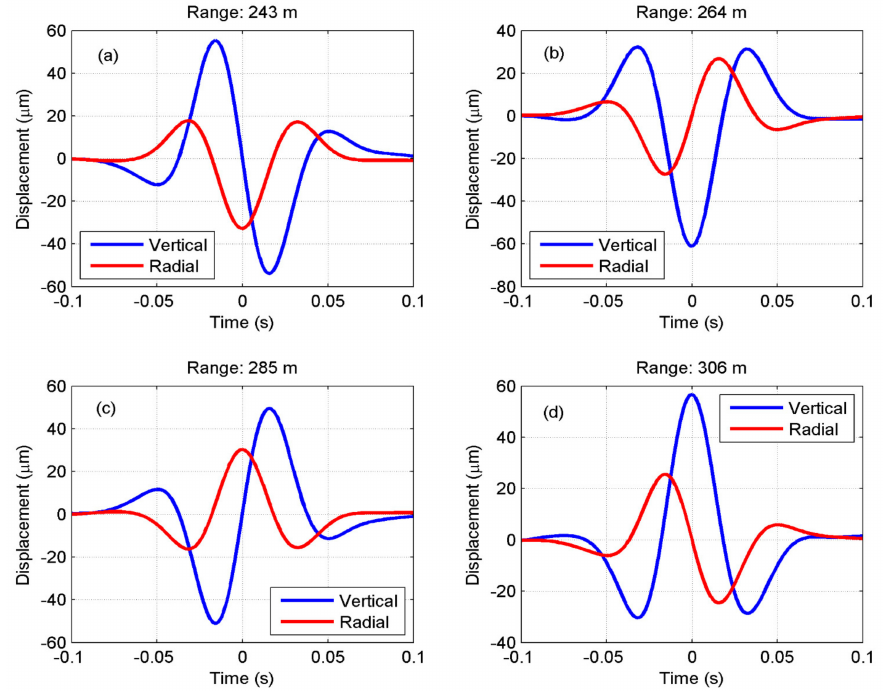
Figure 14. The vertical and horizontal motions of different nodes as the wavelet passes. These nodes are at ranges 243 m, 264 m, 285 and 306 m in plots ( a ) to ( d